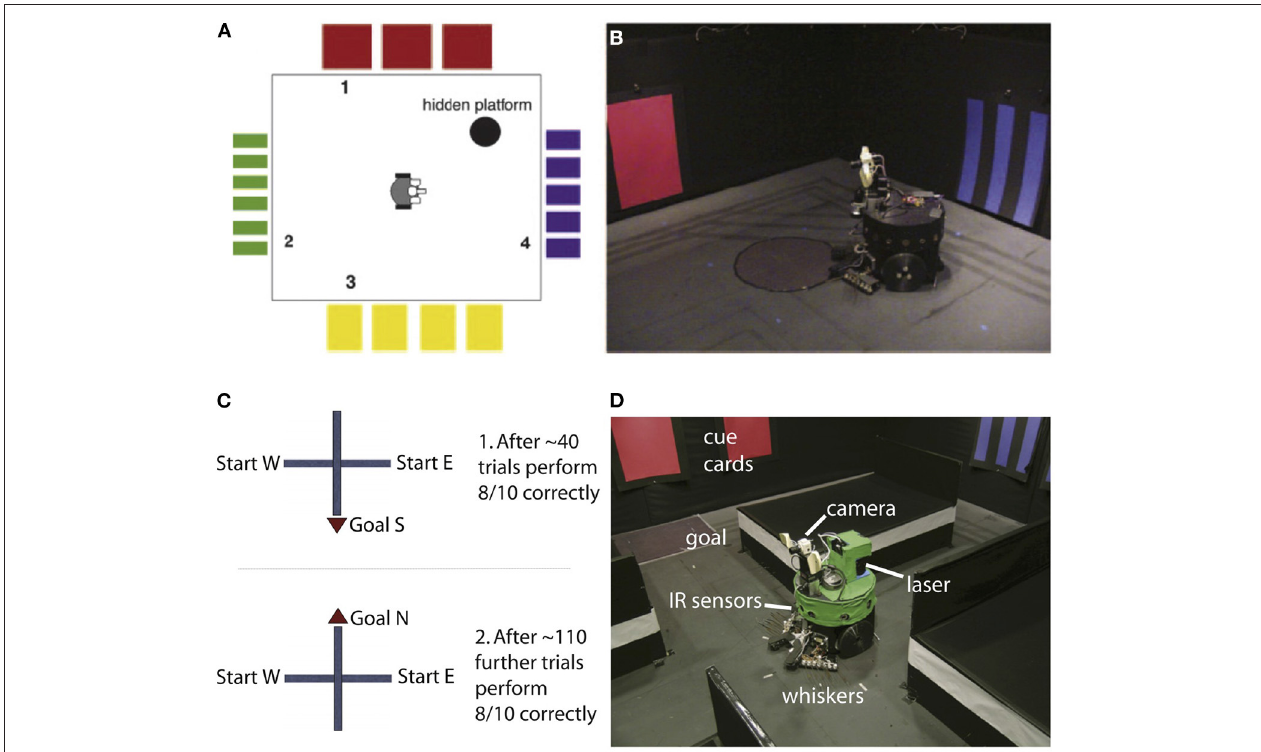
FIGURE 2 | Darwin X experiments for spatial and episodic memory. (A,B) Experimental setup for a dry version of the Morris water maze. Adapted from Krichmar et al. (2005). (C,D) Experimental setup for for place learning with the plus maze. Adapted from Fleischer et al.